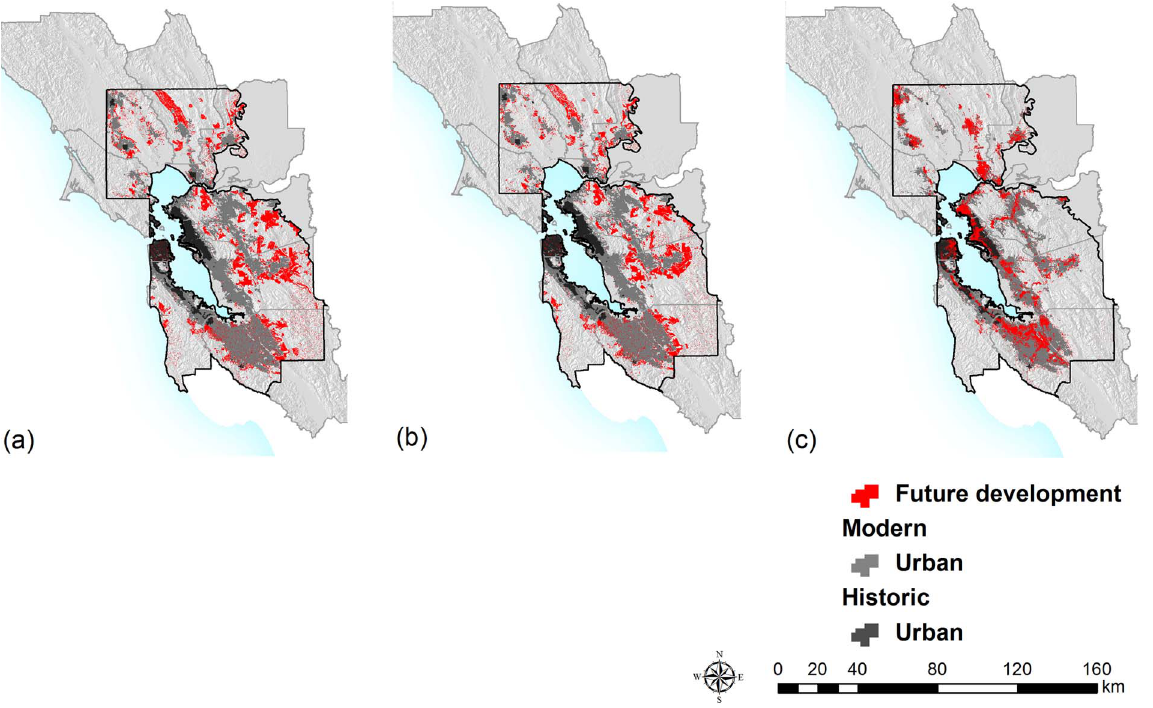
Figure 2. Urban Development trends and projections. (a) Future urban growth by 2050 Business-as-usual scenario (red); (b) Future urban growth by 2050 Smart Growth scenario and (c) Future urban growth by 2050 Infill scenario.